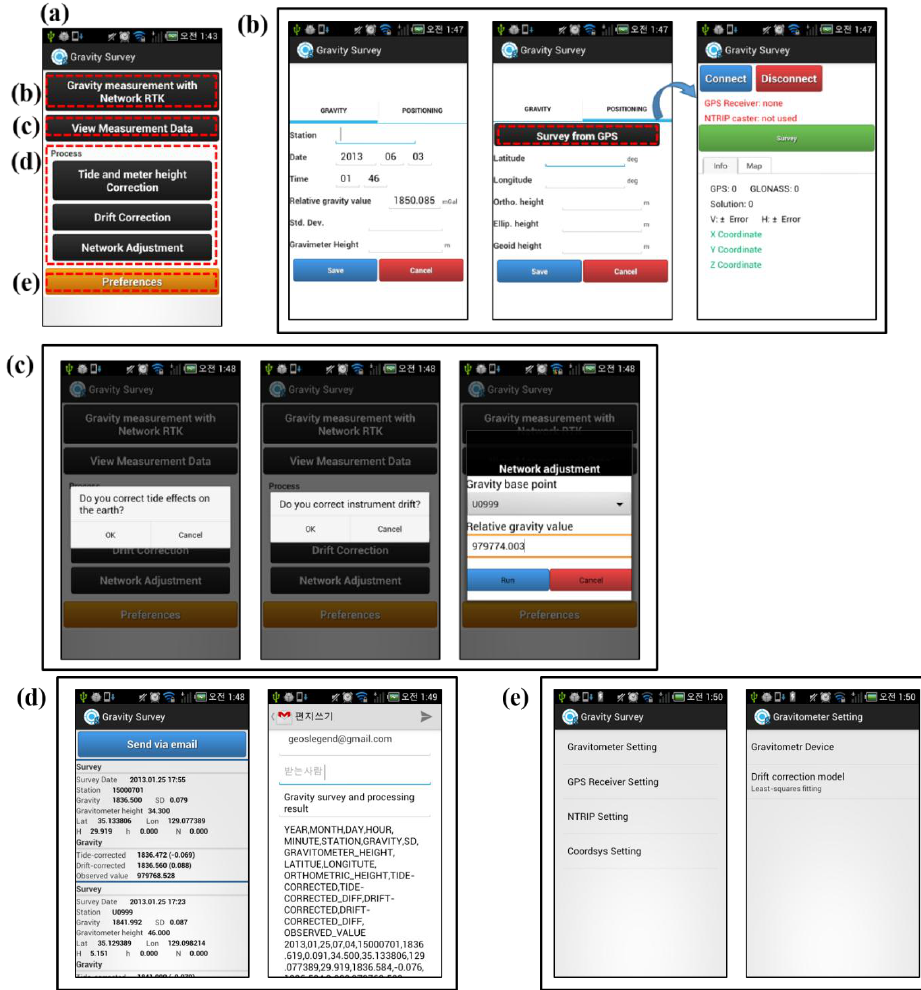
Figure 5. Screen shots of the gravity survey app: ( a ) main screen; ( b ) gravity and 3-D position measurement with the network RTK technology screen; ( c ) tide, meter height, and drift corrections, as well as network adjustment; ( d ) viewing measured data and results (with 3-D position and survey values) and sending them via email; and ( e ) environmental